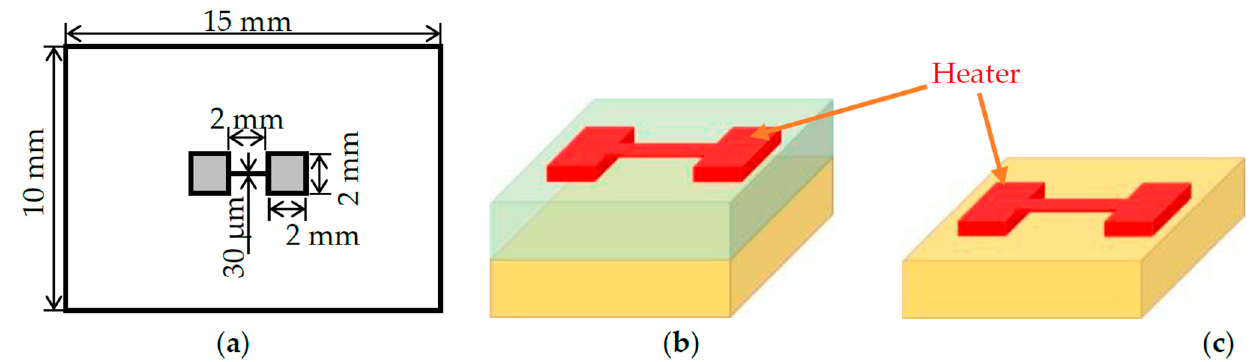
Figure 1. Plan view of the shadow mask of the heater with the length of 15 mm, width of 10 mm and a thickness of 20 µm ( a ) and the schematic diagram of a film sample ( b ) and the reference ( c